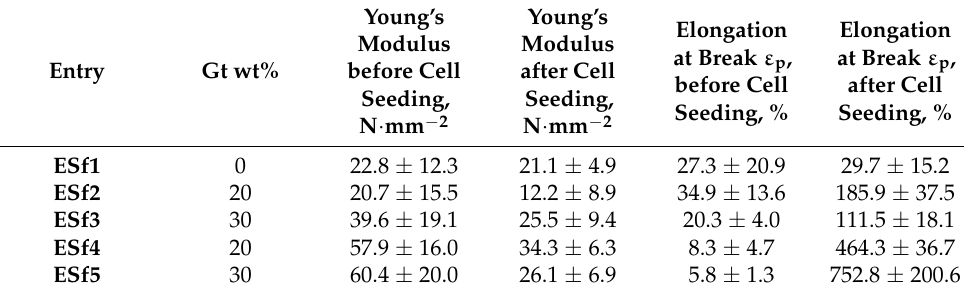
Table 1. Mechanical properties of ES mats 1 .